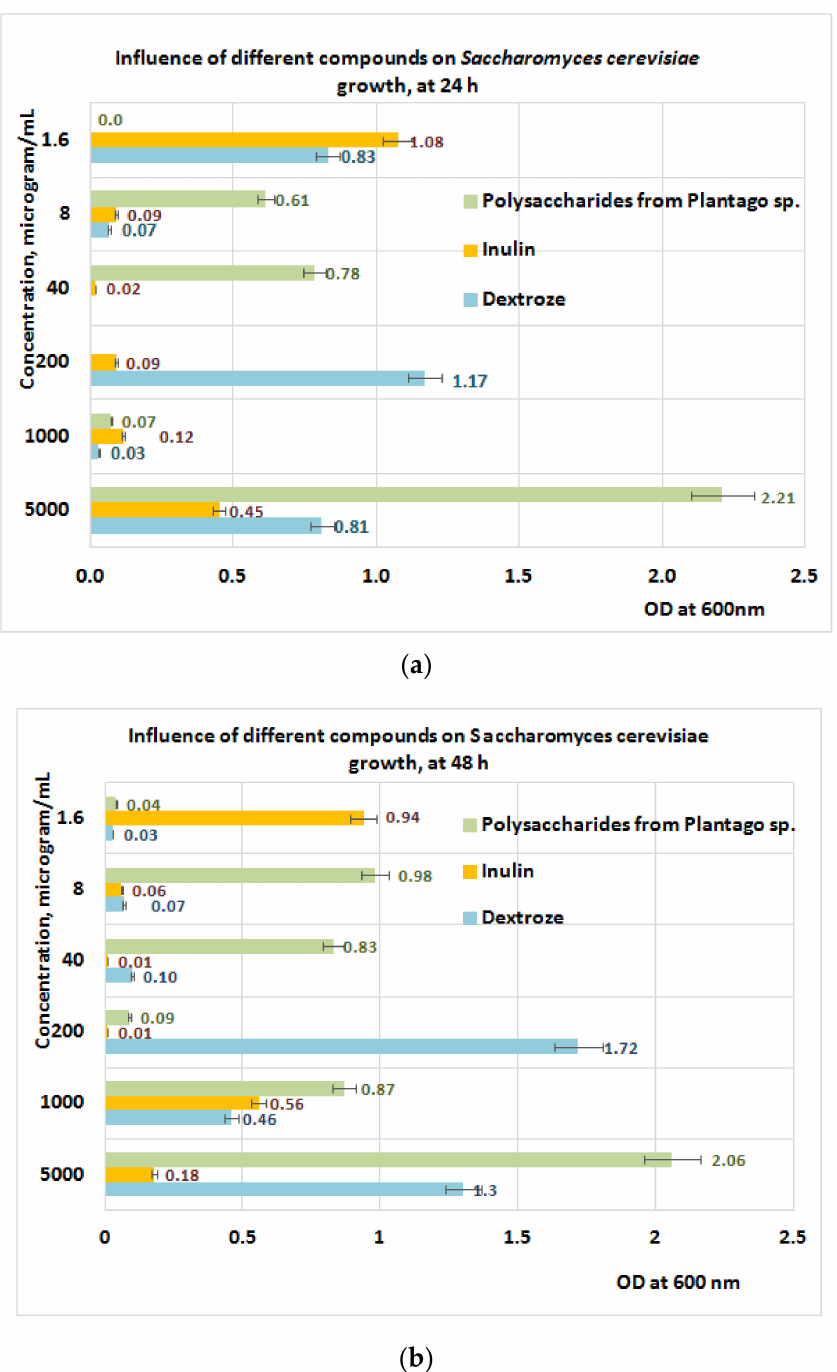
Figure 11. ( a ) Influence of PP on S. cerevisiae growth at 24 h. ( b ) Influence of PP on S. cerevisiae growth at 48